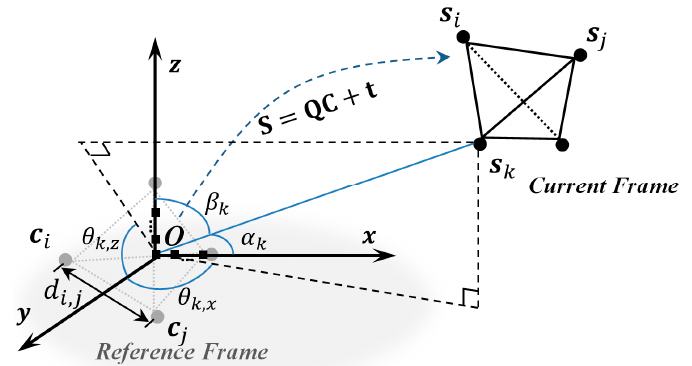
Figure 1. Direction of Arrival (DoA)-based rigid body localization (RBL) scheme in consideration.